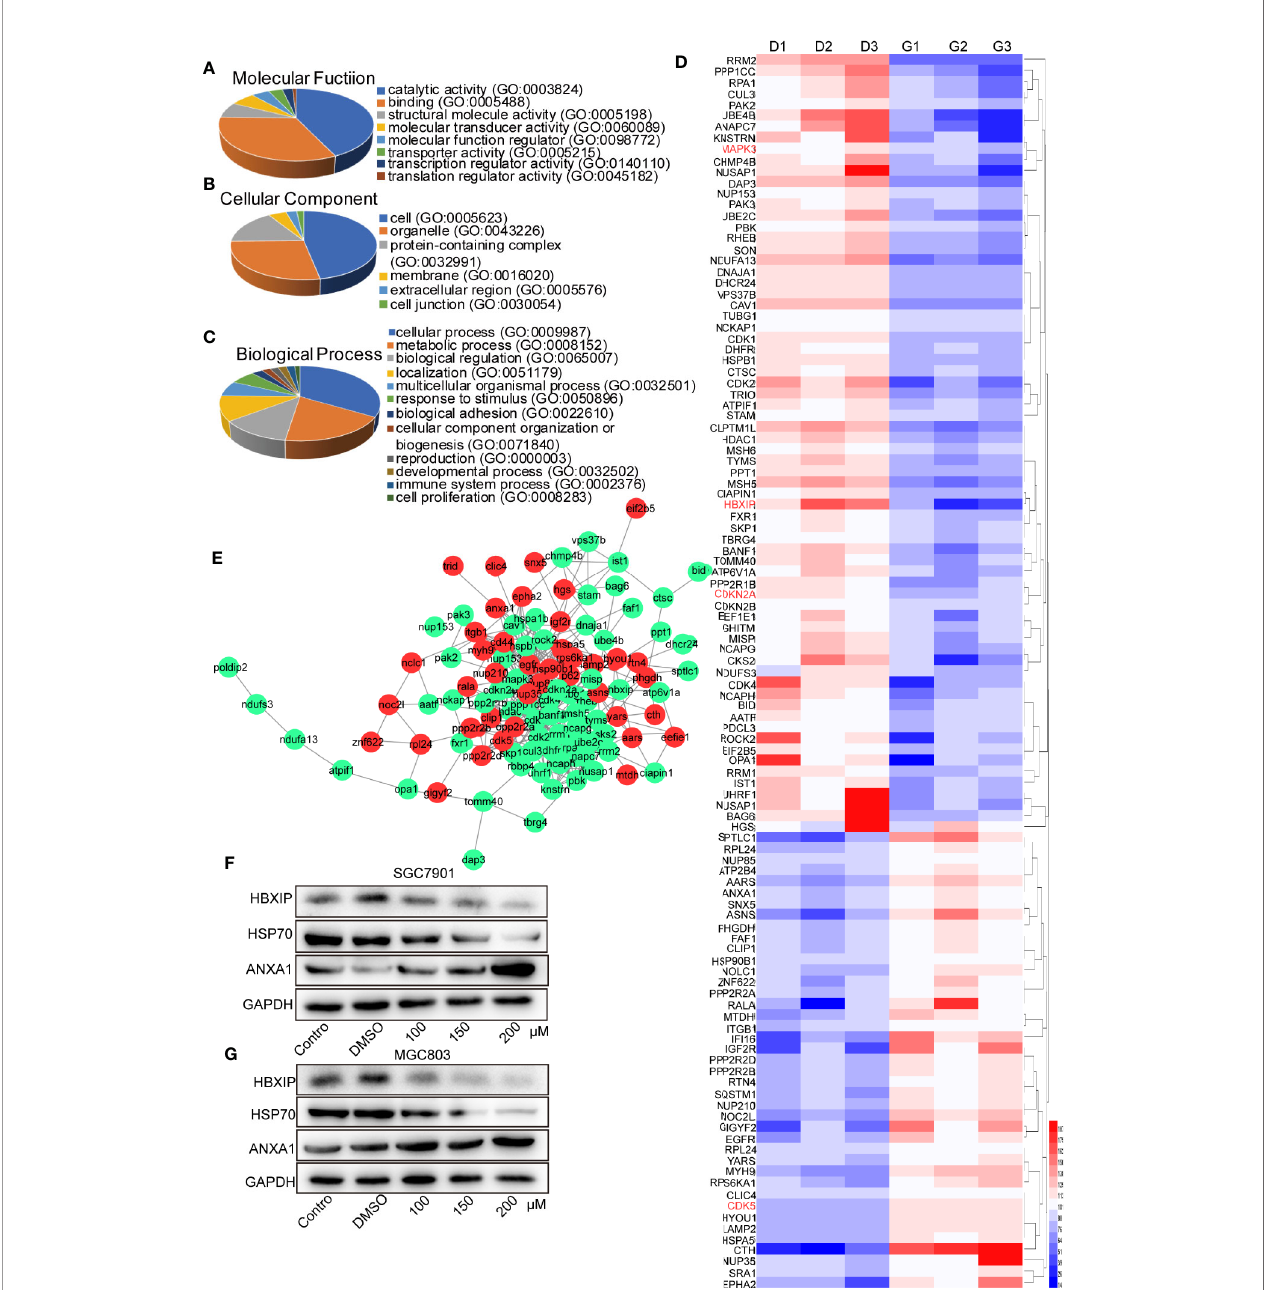
FIGURE 5 | Label-free proteomic and bioinformatic analysis of proteins associated with the cell cycle, apoptosis, and autophagy. (A – C) The DAVID database was used for analysis of molecular function, cellular component, and biological process. (D) A heat map was constructed based on the abundance of 111 proteins. D1, D2, and D3 represent the DMSO 1, DMSO 2, and DMSO 3 groups; G1, G2, and G3 represent the germacrone 1, germacrone 2, and germacrone 3 groups. (E) A protein interaction network was constructed in Cytoscape based on the information provided by the STRING database. Red indicates increased expression of the protein in the germacrone group; green indicates reduced expression of the protein in the germacrone group. (F, G) . The expression of HBXIP, HSP70, and ANXA1 was detected to verify the accuracy of the proteomics